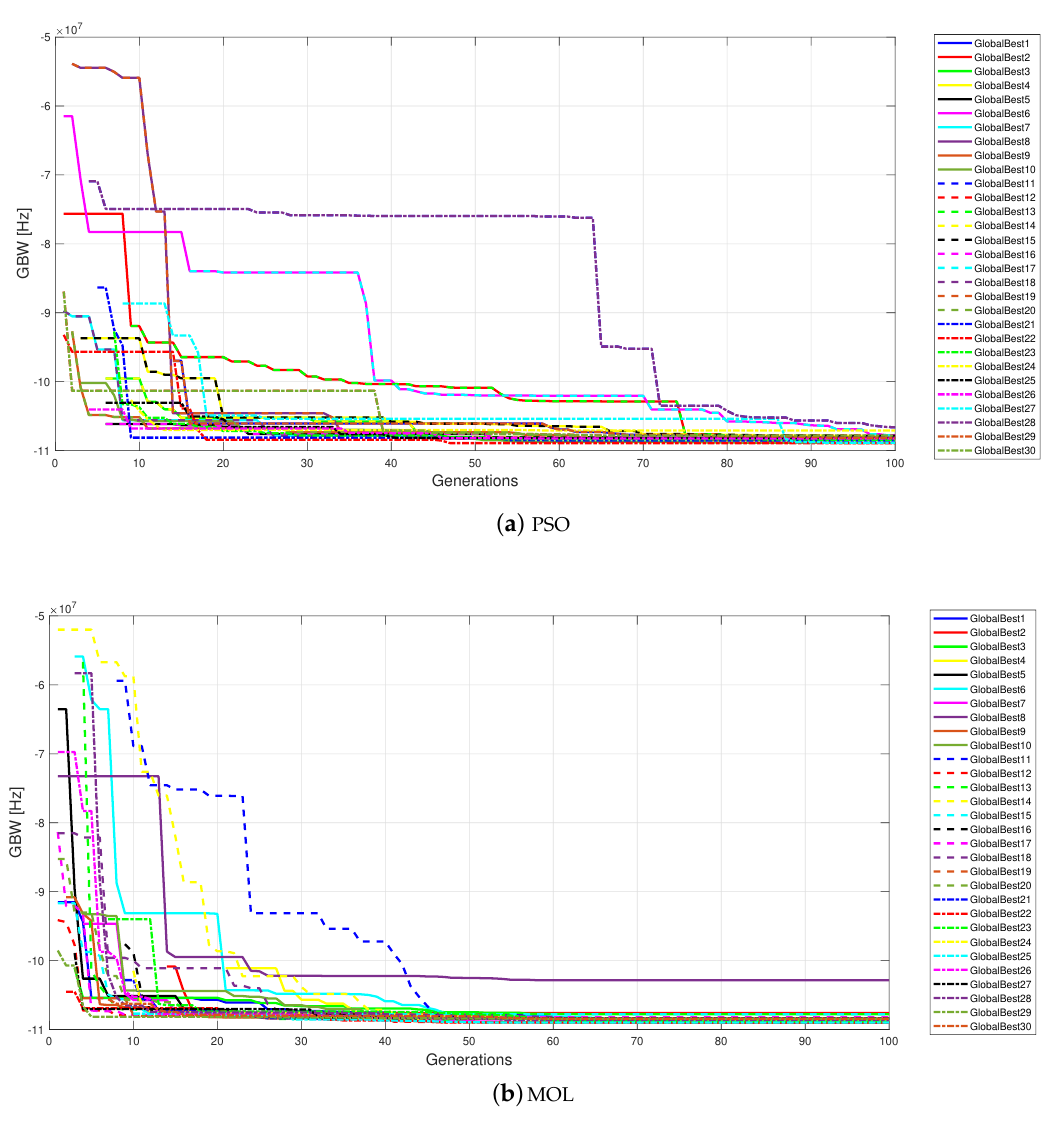
Figure 4. Evolution of the gain-bandwidth product (GBW) of the Miller OTA for 30 runs applying: ( a ) Particle swarm optimization (PSO) and ( b ) many optimizing liaisons (MOL). As recommended in Reference [35], the parameters w and c 2 of the MOL algorithm must be tuned according to the problem at hand. In this work they are set to w = − 0.31 and c 2 = 2.03, and the same parameters are used to size the